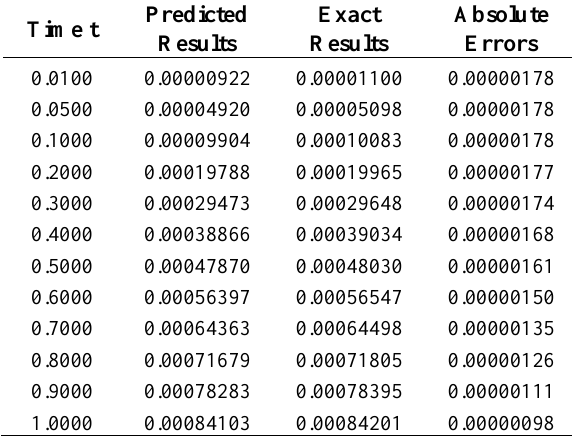
Table 2. Numerical results of the first order stiff differential